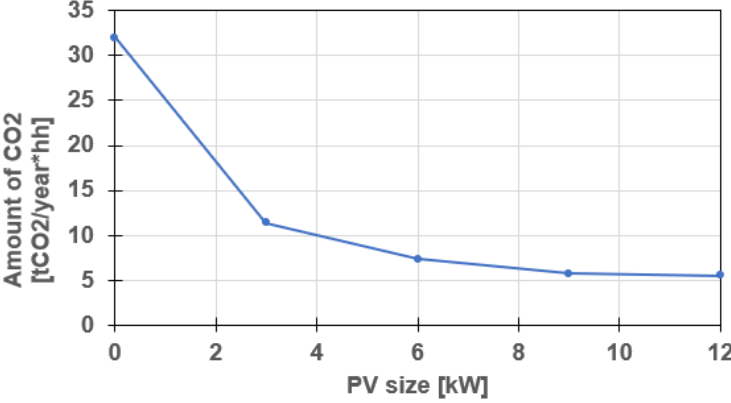
Figure 11. Greenhouse gases